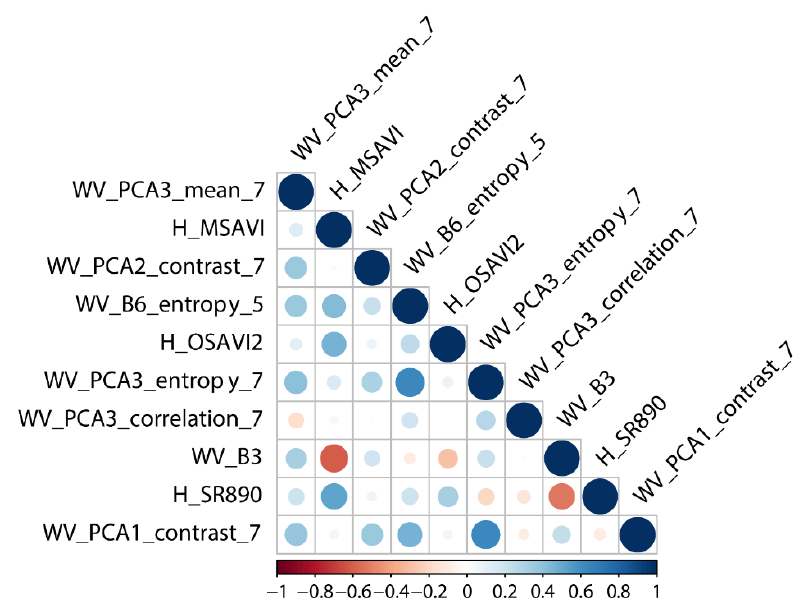
Figure 4. Correlations between the 10 important features.